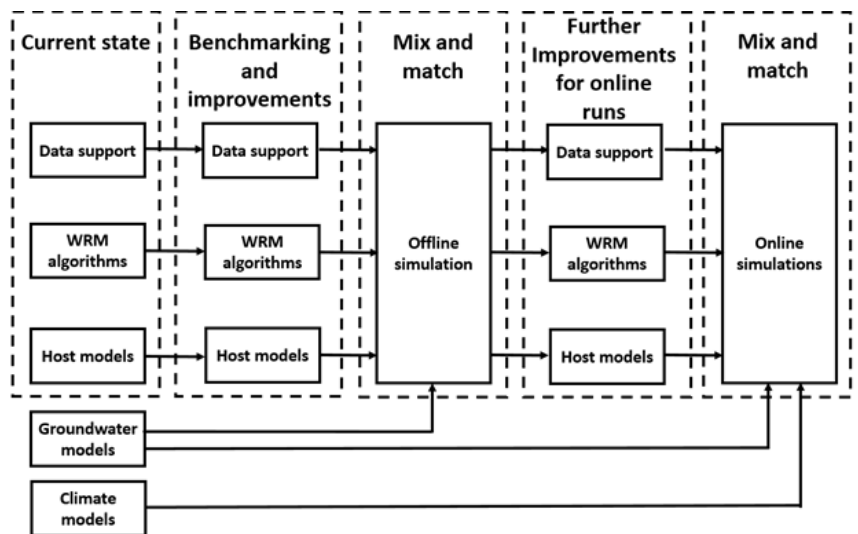
Figure 3. A sequential workflow for benchmarking, improving and including the elements of water resource management into offline and online Earth system